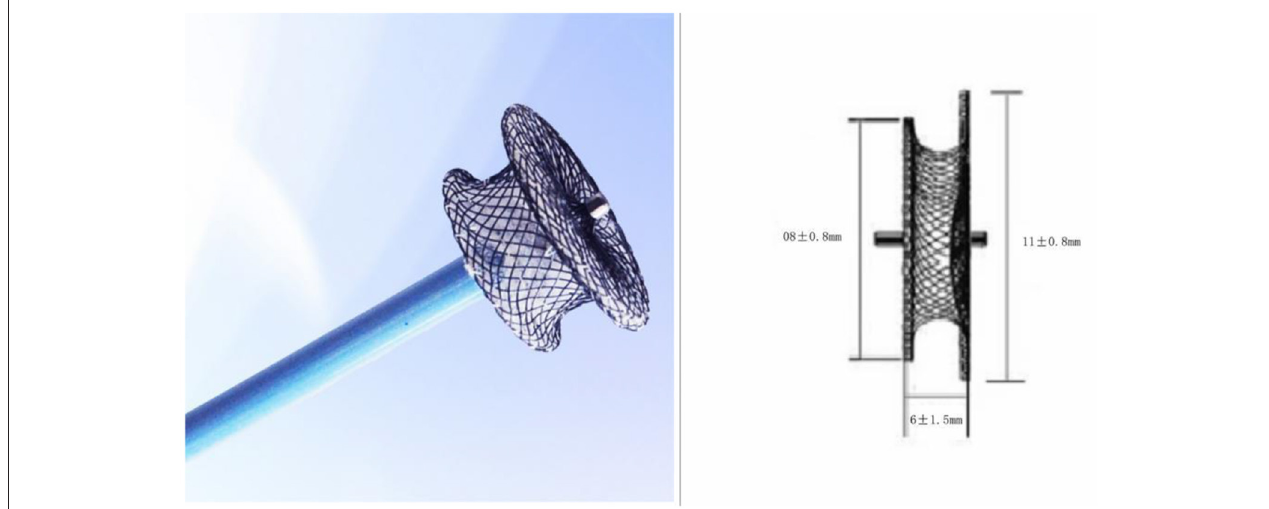
FIGURE 3 | A modified double-disk ventricular occluder was used in this procedure. The left umbrella disk is slightly larger than the right umbrella disk.